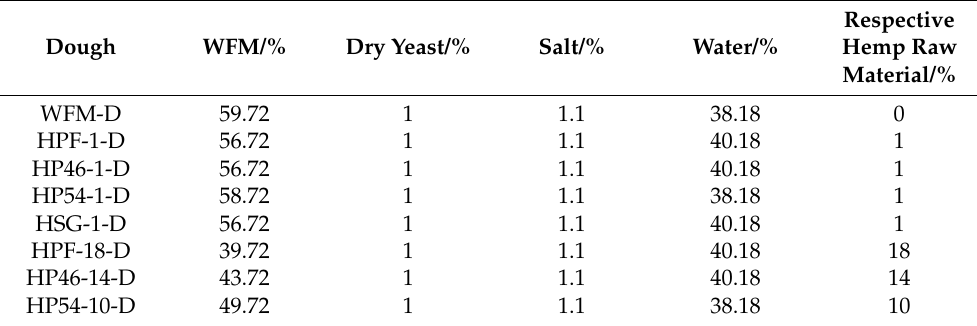
Table 5. Ingredients for all prepared doughs/breads. HSG—hemp seed grit; HPF—hemp press cake flour; HP46—hemp press cake flour protein (46%); HP54—hemp press cake flour protein (54%); WFM—half-and-half mixture of wheat and whole wheat